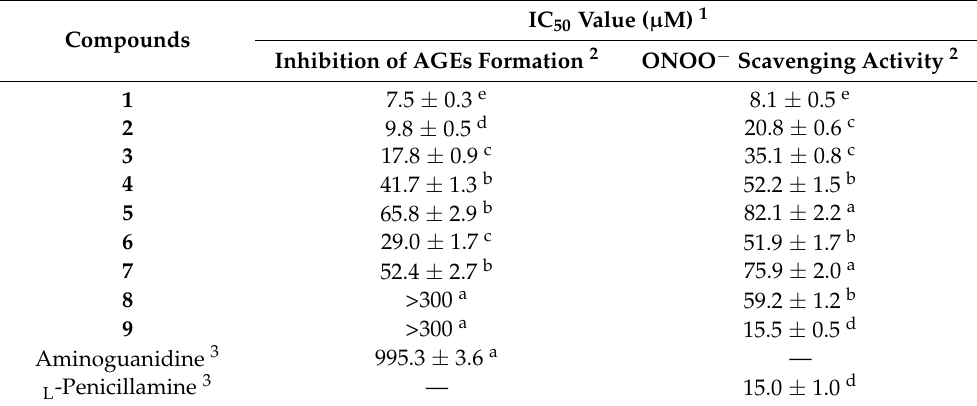
Table 2. Effects on the inhibition of AGEs formation and ONOO − scavenging activities of the isolated compounds 1 – 9